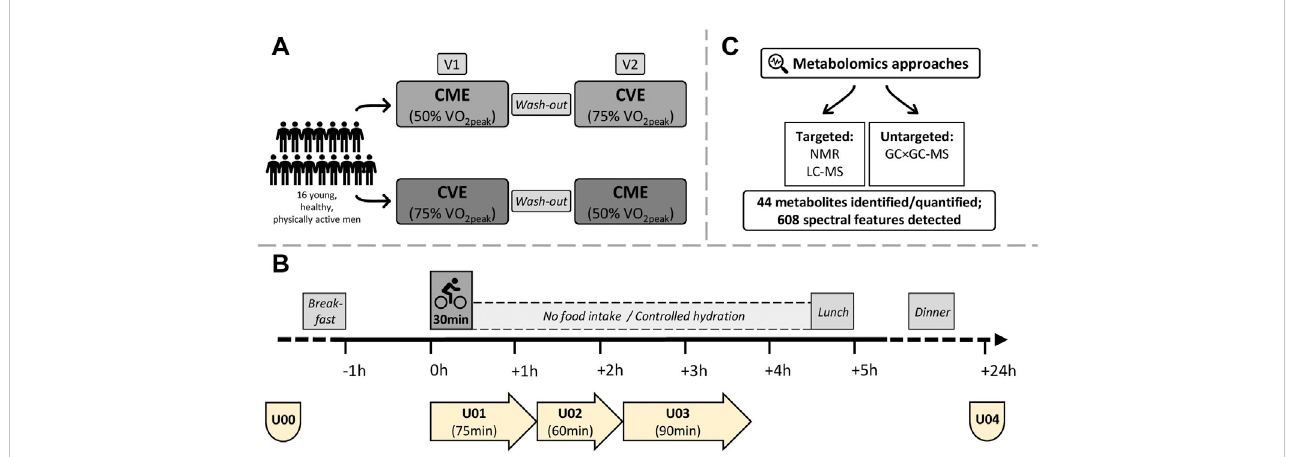
Study design, urine sample collections, and metabolomics approaches. (A) Participants were randomized to 30 min of CME or CVE at V1 or V2, respectively. (B) Fasting spot urine samples were obtained in the morning of V1 and V2 (U00) and after 24 h (U04). Three urine collection phases covered the (post-)exercise periods (U01: urine produced during exercise trials until 45 min post-exercise; U02: urine produced from 45 to 105 min post-exercise; U03: urine produced from 105 to 195 min post-exercise. (C) 44 metabolites were identi fi ed and quanti fi ed by targeted NMR or targeted LC-MS. 608 spectral features were detected by untargeted